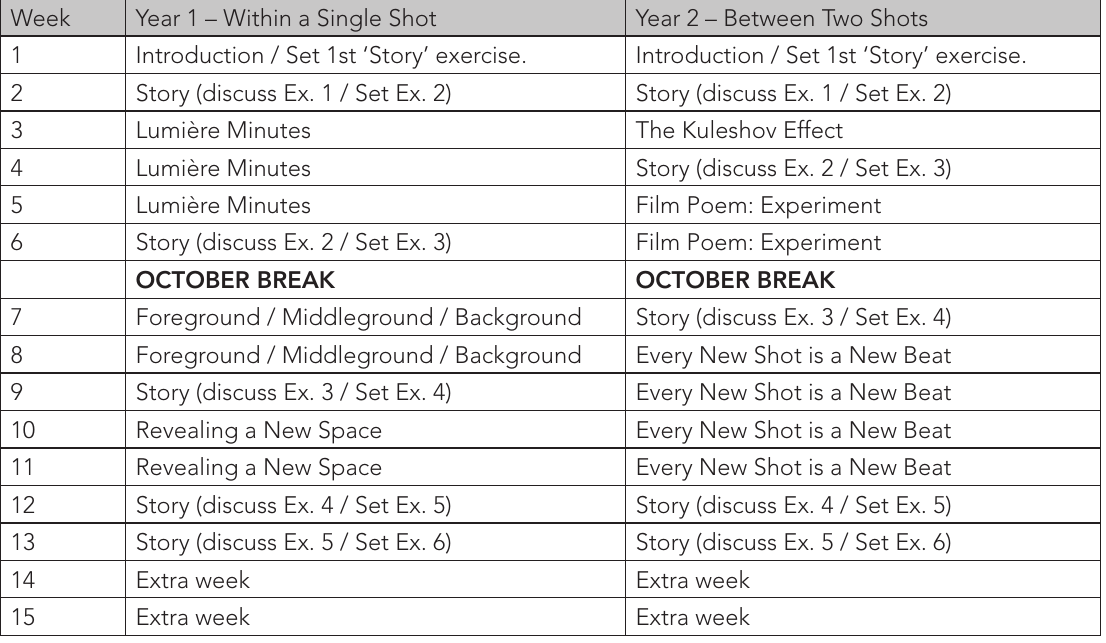
Table 2. Our Cinema schedule Time has been allocated for certain exercises to be tried twice, or for extra time if time is running short.